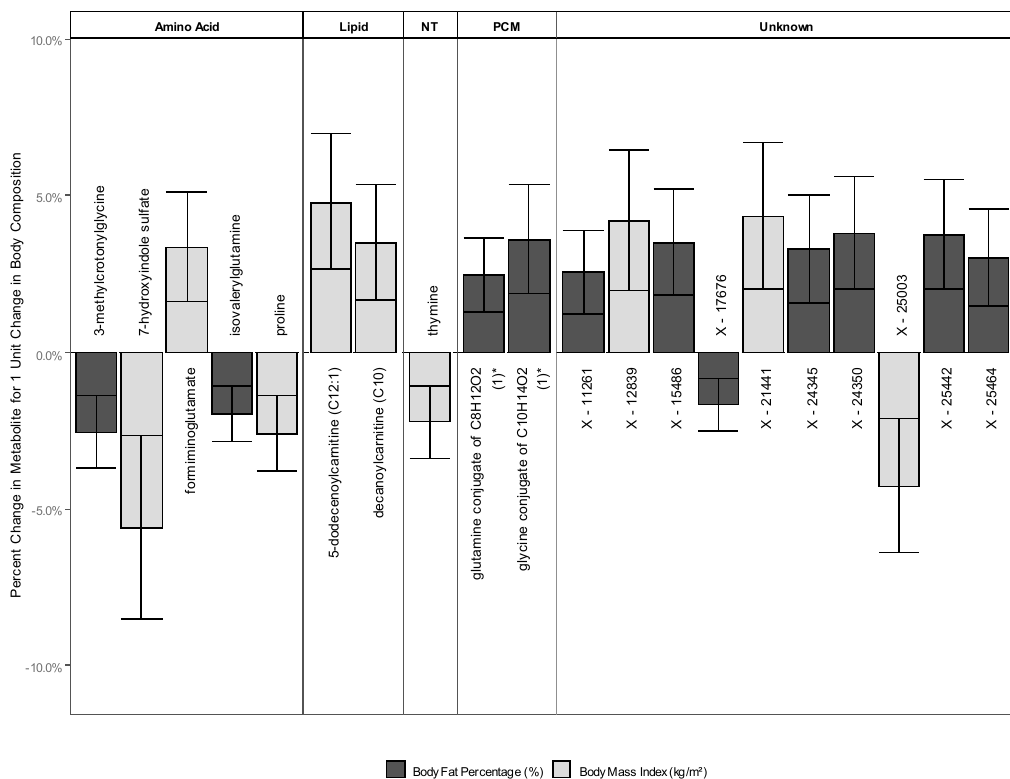
Figure 2. Metabolites associated with either BMI or BF. Estimates are back-transformed linear regression beta coefficients, regressing metabolites on body composition (BMI or BF). BMI units are kg/m 2 and body fat units are percent. Abbreviations: NT, nucleotide; PCM, partially characterized molecules.